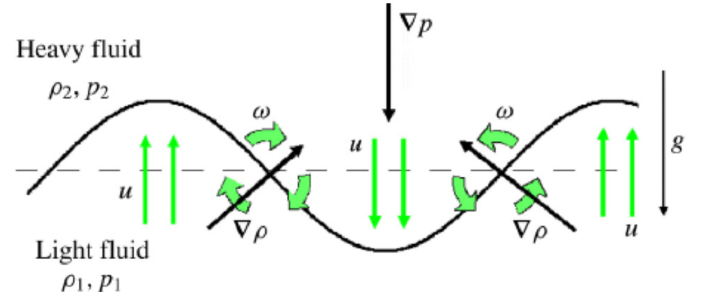
Figure 4. Initial interface perturbation of flow instability with sinusoidal wave in two space dimensions [12].